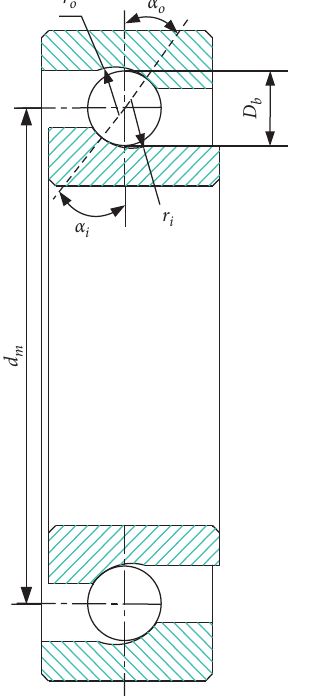
Figure 1: Basic mechanism of angular contact